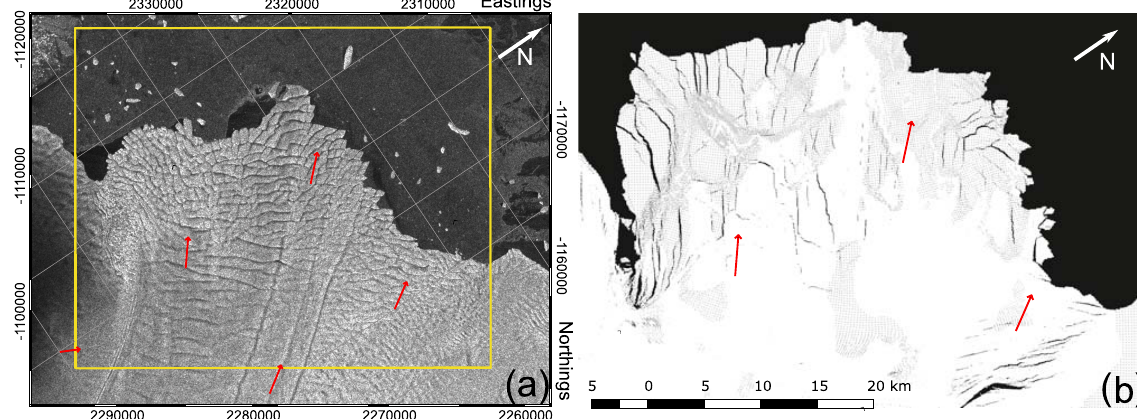
Figure 2. Observed and modelled fractures. (a) Background image from Sentinel 1 (December 2016) shows the dense pattern of fractures at the calving front (yellow box indicates model domain). (b) Modelled crevasses in HiDEM occur most densely near the calving front and typically run roughly parallel to flow or perpendicular to calving front. Red arrows show flow direction from the NASA Making Earth System Data Records for Use in Research Environments (MEaSUREs) program Antarctic velocity map (Mouginot et al., 2017a, b). In this projection thick ice appears white, thin ice appears grey and water appears black. The dark fractures on the shelf are full-thickness rifts exposing the black water underneath.